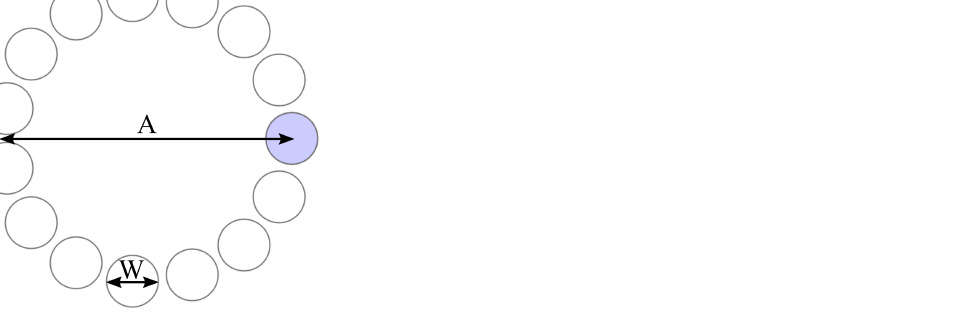
Figure 11. FittsTaskTwo [23,24] click test with the target’s diameter W set to 90 pixels and the amplitude A set to 500 pixels in this example. The target to be clicked is the circle filled in with color.